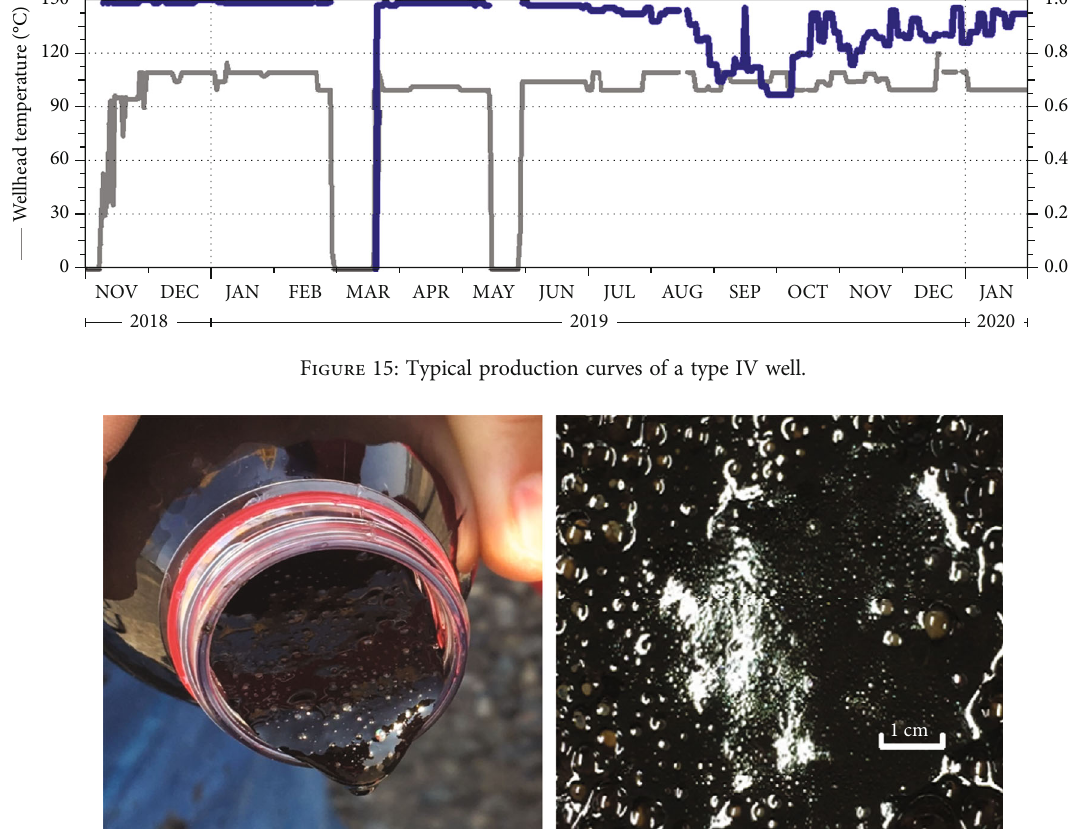
-steam coinjection [7, 2